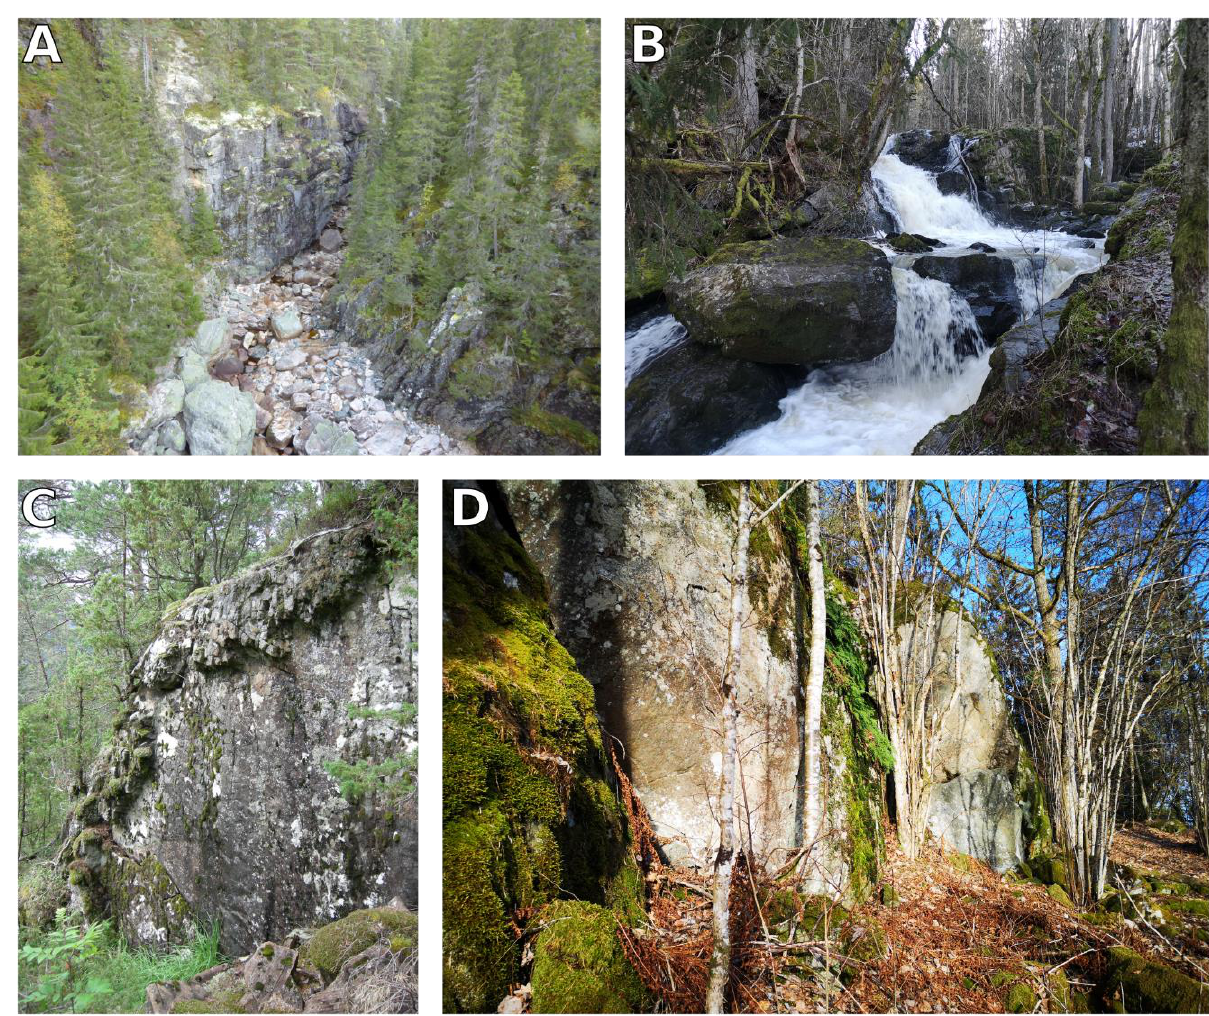
Figure 2. Examples of stream gorges ( A , B ) and rock walls ( C , D ). Pictures not from the study area. Photos by Rune Halvorsen licensed CC-BY-4.0 ( A , C ) and Hans Ole Ørka ( B , D ). In total, 15 WKH were recorded by the two companies covering 21.51 ha (Table 1). The two companies identified nine rock walls covering 3.57 ha and six stream gorges covering 16.55 ha. Companies A and B recorded six and three rock walls in subarea I, respectively (Figure 1). None of the recorded rock-wall habitats overlapped. Company A recorded five stream gorges in both areas, while company B delineated one stream gorge. This stream gorge was also identified by company A in subarea